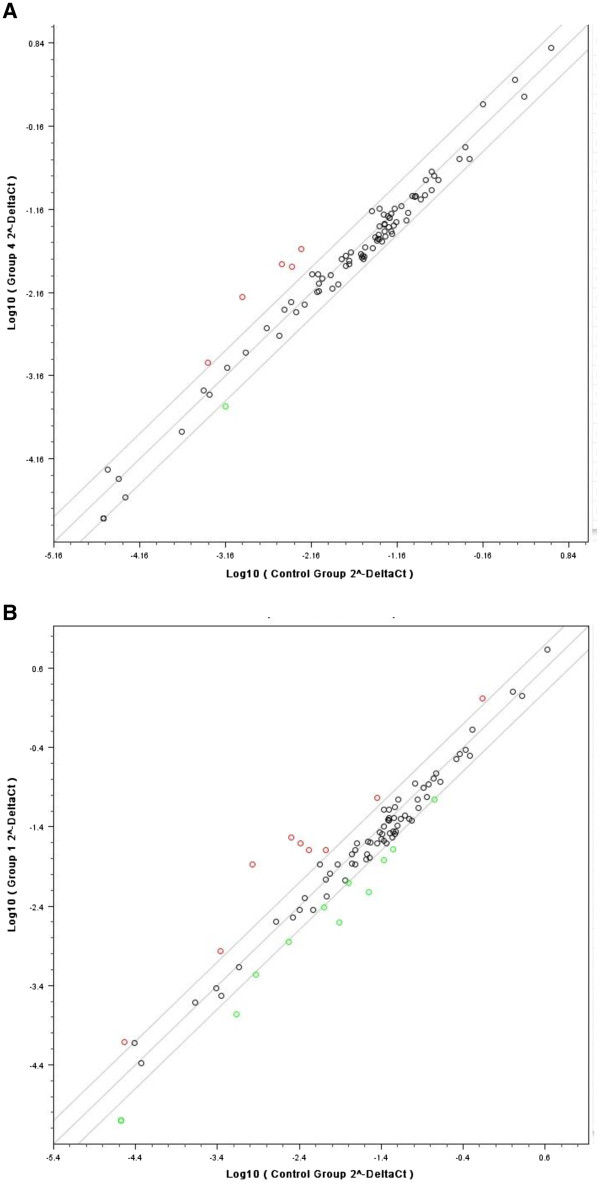
Real time PCR analysisof the changes inexpression of 84 genesinvolved in DNA damagesignalling/repair pathways, following exposureof cells to ICLagent.A: Prior to RNA extraction, A549 cells were treated with melphalan at 50 μM for 1 hour followed by 16 hours post-incubation to allow peak ICL formation. The mean expression from three individual drug treatment repeat samples are compared to three individual non-drug treated control samples. Genes which show increased expression by more than 2-fold compared to control cells following drug treatment are shown in red and those which show decreased expression in green. B: As above, but A549 cells were treated with cisplatin at 150 μM for 1 hour followed by 9 hours post-incubation to allow peak ICL formation.